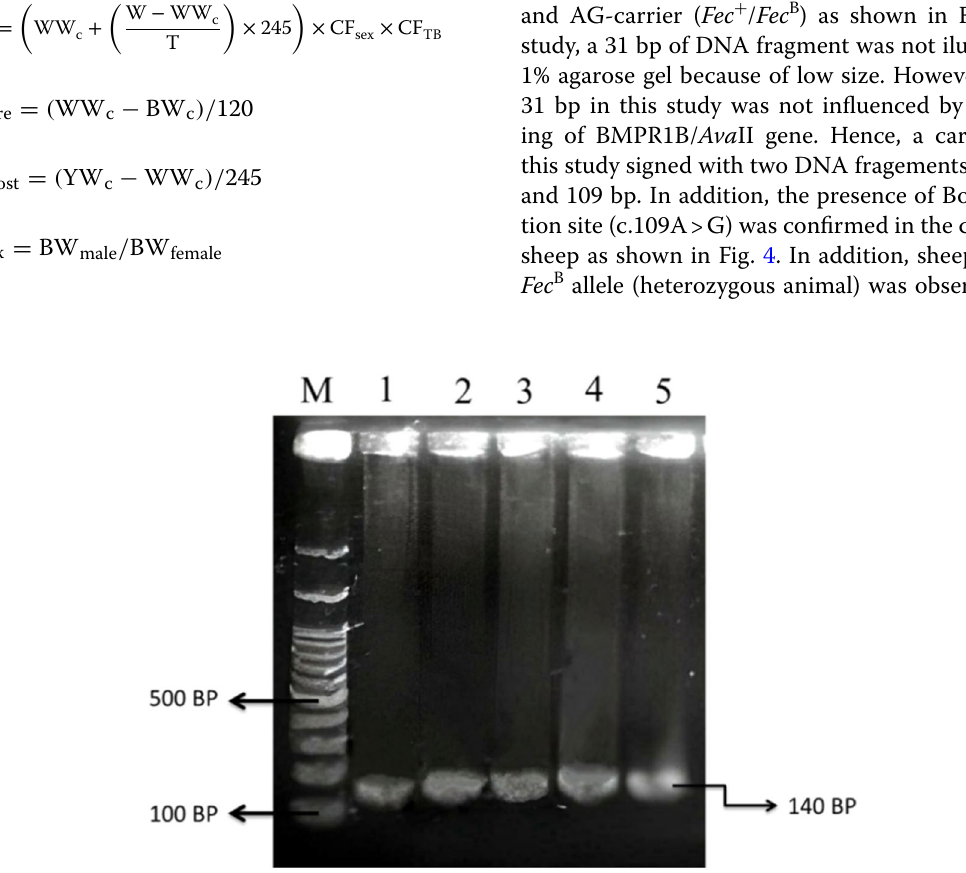
Fig. 2 The PCR results for BMPR1B gene in MEGA sheep with presence of DNA fragment (amplicon) along 140 bp in the 1% of agarose gel. M: DNA marker 100 bp; Line 1–5: DNA